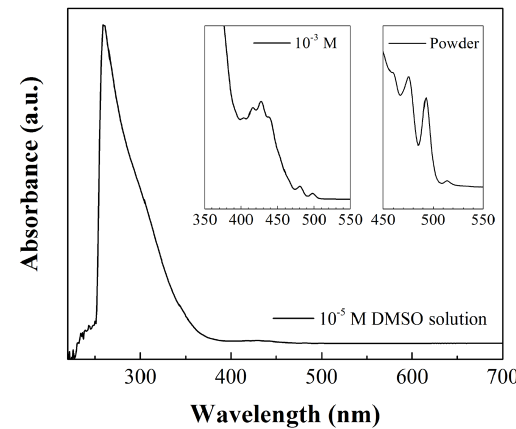
Fig. 5. Absorption spectrum of [UO DMSO solution. Left inset : detail of the absorption spectrum in a 10 -3 M DMSO solution. Right inset : detail of the diffuse reflectance spectrum in powder